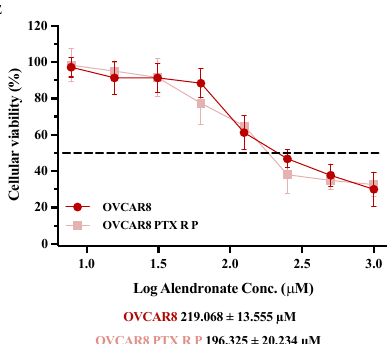
Figure 1. Repurposed drugs demonstrate high efficacy in reducing cellular viability of chemoresistant high-grade serous carcinoma cells. ( A – E ) Dose–response curves for OVCAR8 and OVCAR8 PTX R P cells obtained by Presto Blue assay after exposure to increasing concentrations of ( A ) Pitavastatin (0.04 to 5 μ M), ( B ) Metformin (0.08 to 10 mM), ( C ) Ivermectin (0.39 to 50 μ M), ( D ) Itraconazole (0.39 to 50 μ M) and ( E ) Alendronate (7.81 to 1000 μ M) for 48 h. IC 50 values are represented by a dot line in each dose–response curve and mentioned bellow. All assays were performed in triplicate in at least three independent experiments. Data are expressed as mean ± standard deviation and plotted using GraphPad Prism Software Inc. v8 (GraphPad Software Inc., San Diego, CA, USA). Statistical analysis was performed using ordinary two-way ANOVA followed by Šid á k multiple comparison test ( A – E